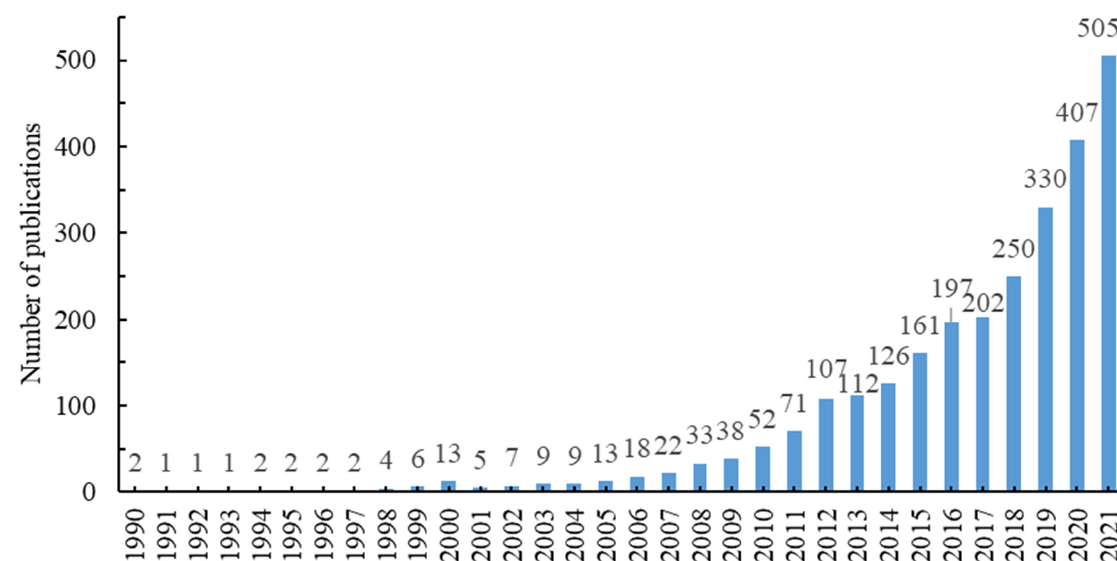
Figure 1. Number of publications on social vulnerability research from 1990 to 2021.